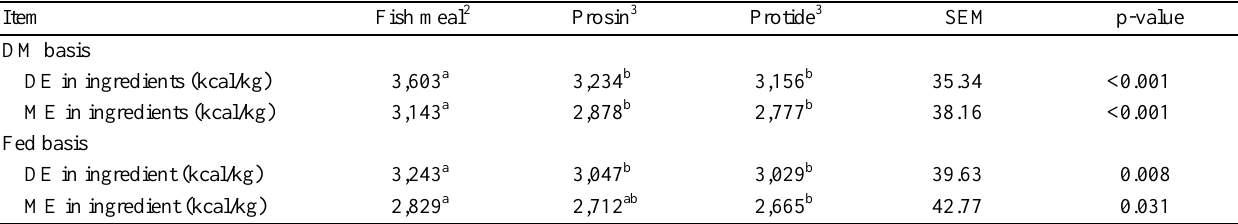
Table 5. The DE and ME contents in fish meal and single-cell proteins (Prosin and Protide) (as-fed basis), Exp. 1 1 Item Fish meal 2